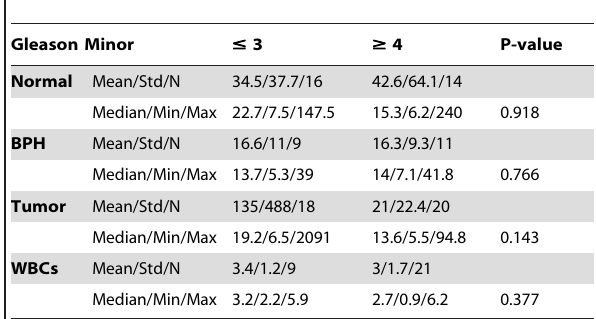
Table 5 . Comparison of mtDNA content in normal, BPH, tumor, and WBCs between different Gleason grades (Gleason